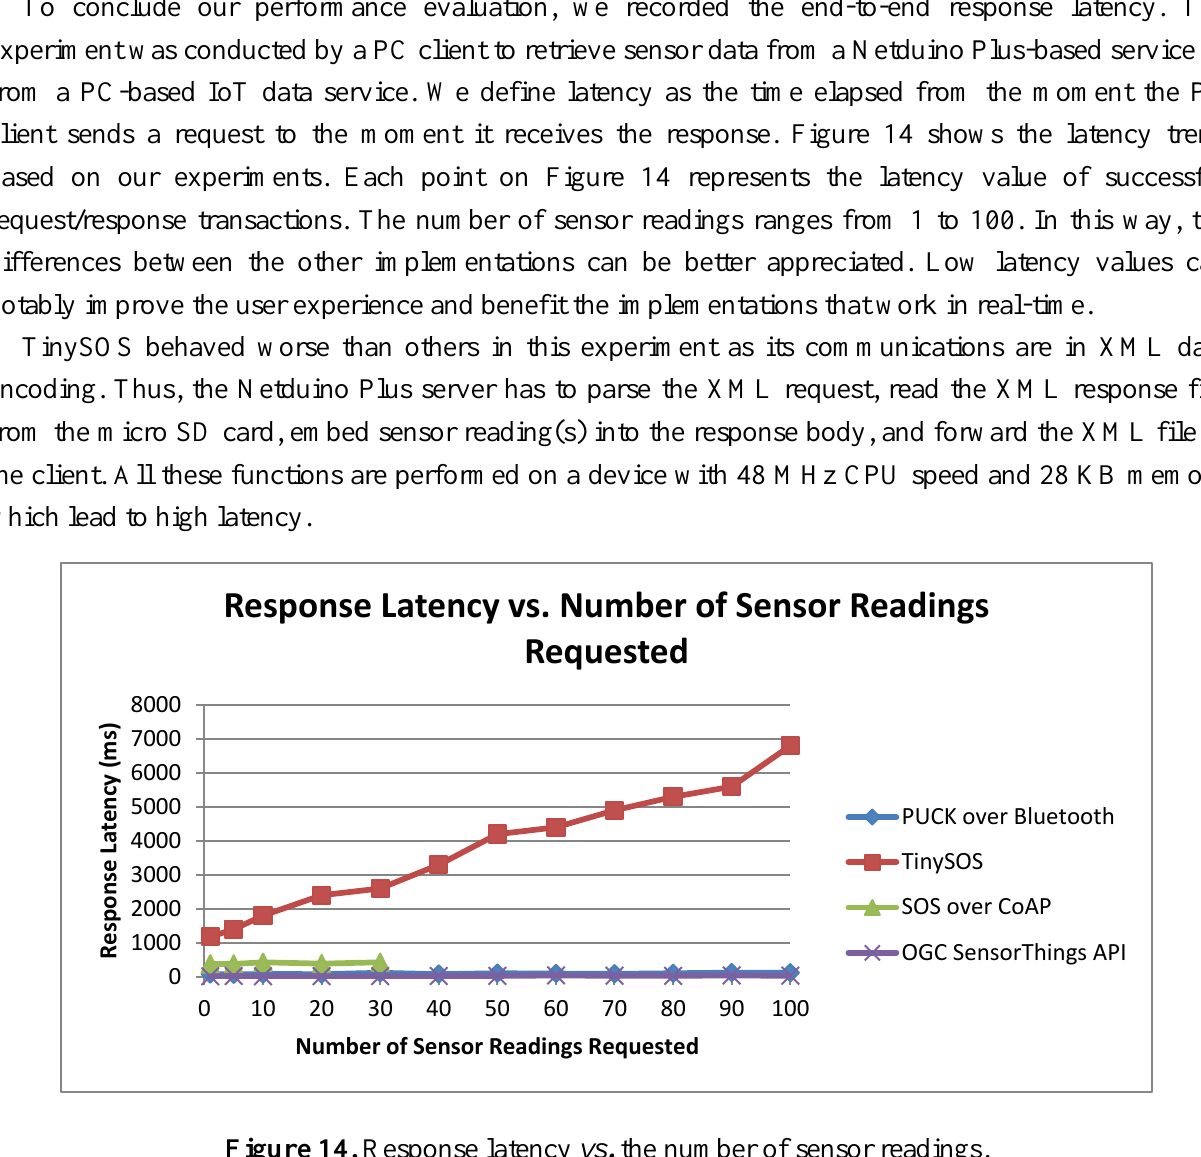
Figure 14. Response latency vs. the number of sensor